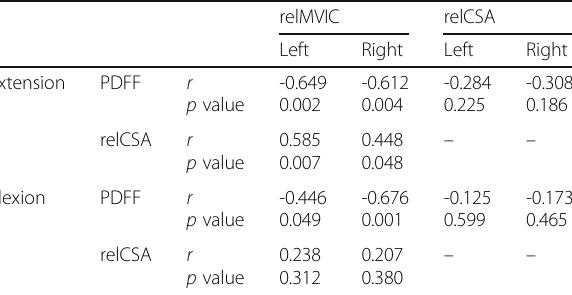
Table 2 Correlation between the proton density fat fraction (PDFF) or relative cross-sectional area (relCSA) and relative maximum voluntary isometric contraction (relMVIC) in